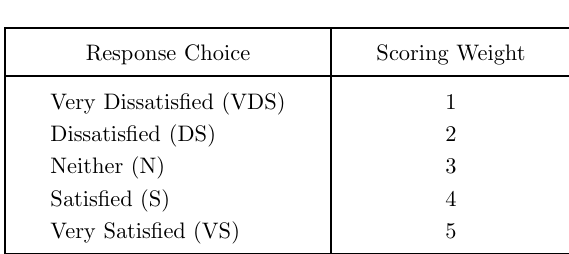
Scoring Response Choice Scoring Weight Very Dissatisfied